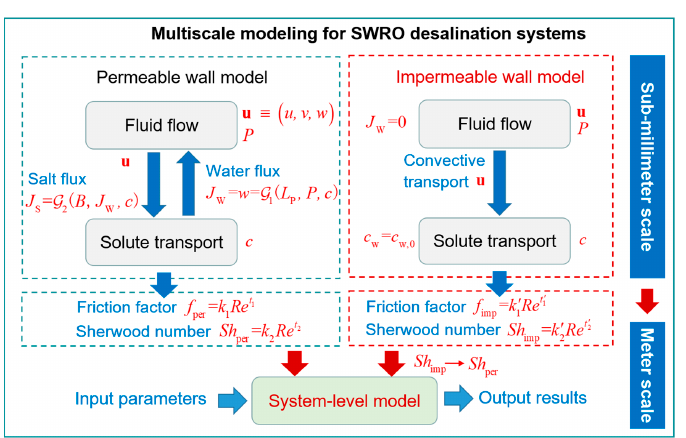
Figure 1. The multiscale modeling framework for SWRO desalination that integrates the permeable wall model and the impermeable wall model. wall model and the impermeable wall